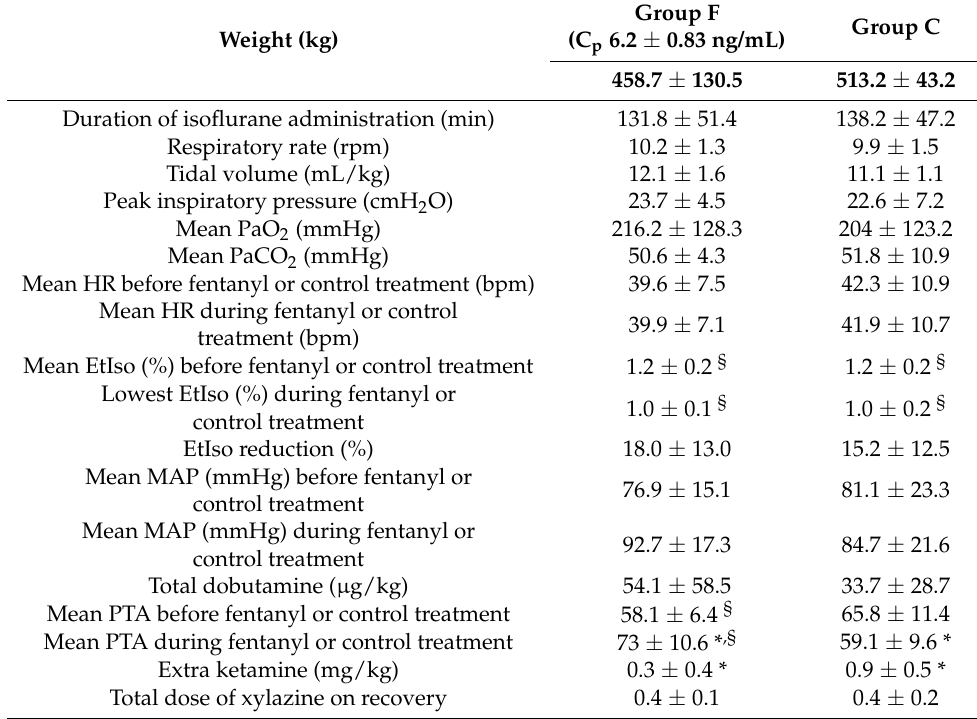
Table 1. Mean values for pre- and intraoperative variables in fentanyl and control